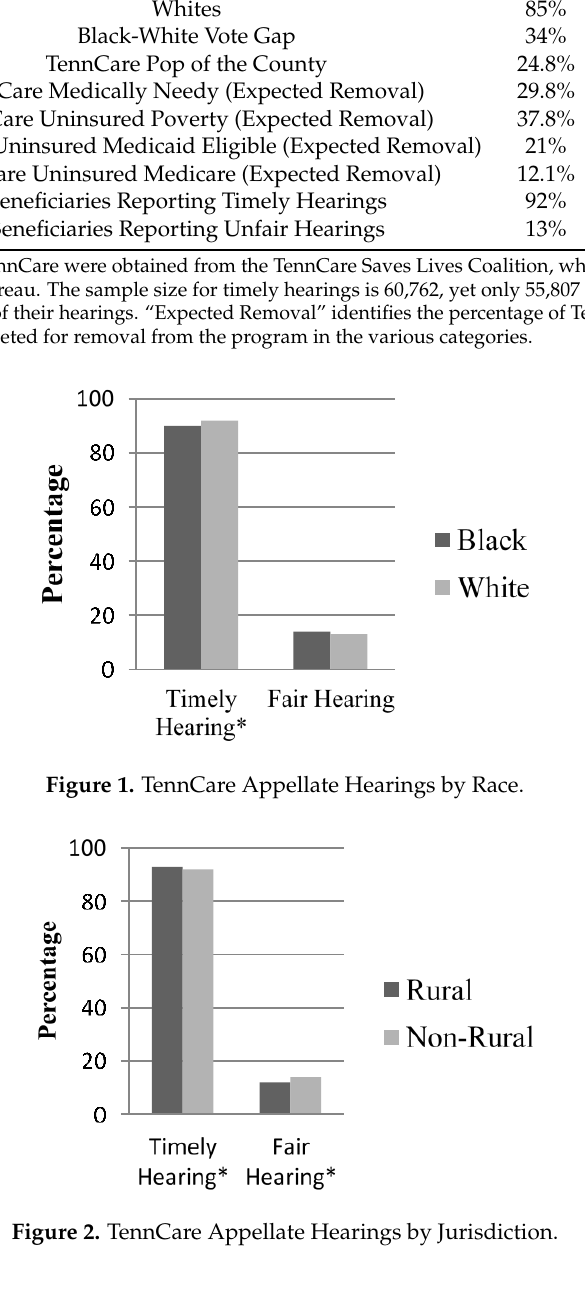
Figure 3. TennCare Appellate Hearings by Priority County. Next, the study provides a closer examination of the procedural outcomes of the administrative